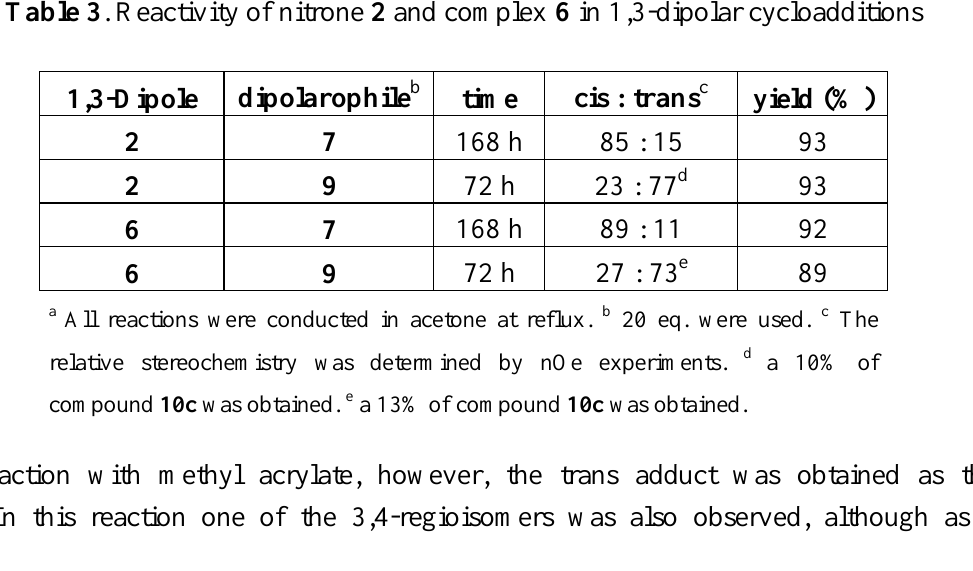
Table 3 . Reactivity of nitrone 2 and complex 6 in 1,3-dipolar